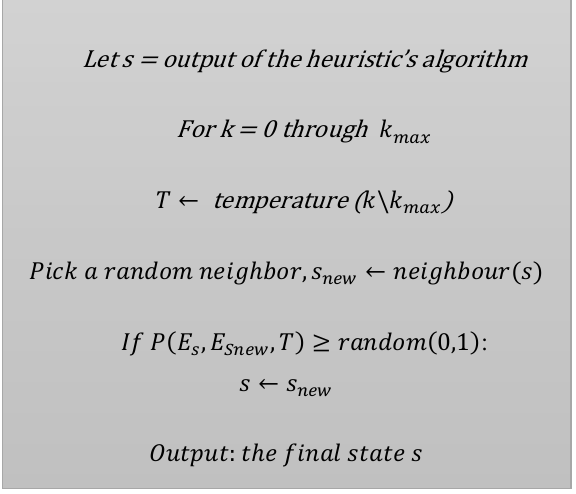
Figure 9. The hybrid SA algorithm.